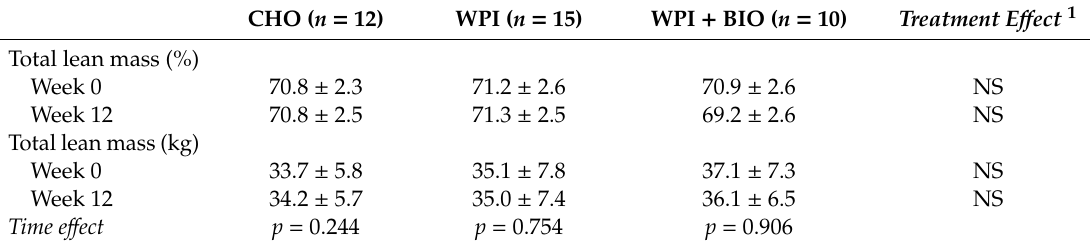
Table 4. Total lean mass determined by bioelectrical impedance analysis of elderly subjects with limited mobility treated with a combination of EMS and nutritional supplement: CHO, WPI or WPI + BIO for 12